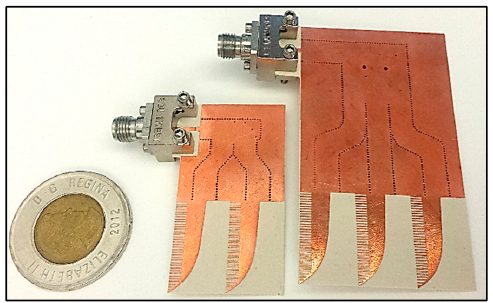
Figure 9. Fabricated prototypes of H-plane SIW antenna arrays with two-way and three-way right-angled power dividers and size comparison with a Canadian two-dollar coin.